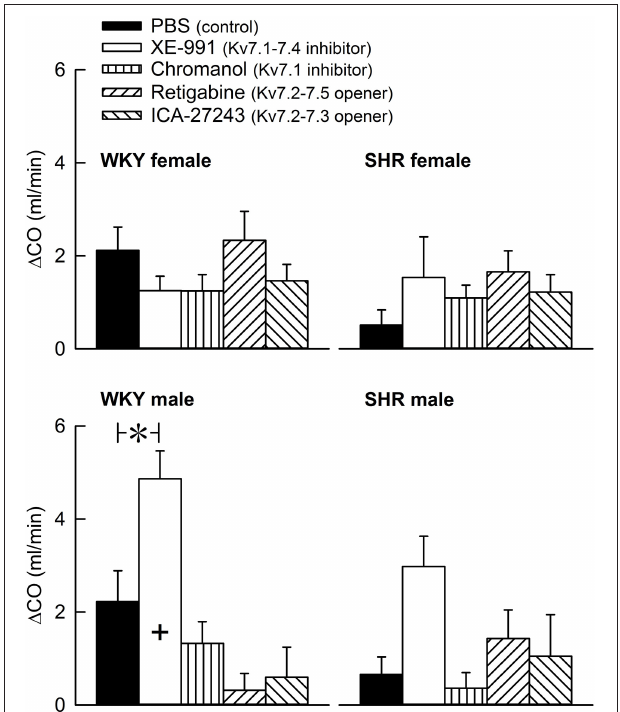
FIGURE 4 | The acute effect of Kv7 inhibitors/openers on CO baseline. The rats were pre-treated with PBS (controls) or Kv7 inhibitor or opener, as indicated by the symbol legends. The change in CO compared to baseline was recorded at the time of the maximum change in TPR ( Figure 2 ). Comparisons were made between corresponding PBS-control and experimental groups, and for corresponding experimental groups across sex ( + within column) or strain (none detected). Analyses were done by one-way ANOVA, followed by Student’s t - or Kruskal–Wallis test. * P ≤ 0.0125.